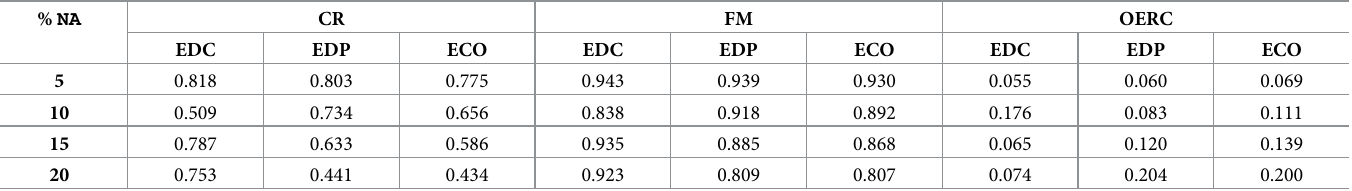
Table 7. Performance of the VKFCM-K-LP clustering algorithm with the WDS, PDS and OCS strategies for the Thyroid Gland dataset.